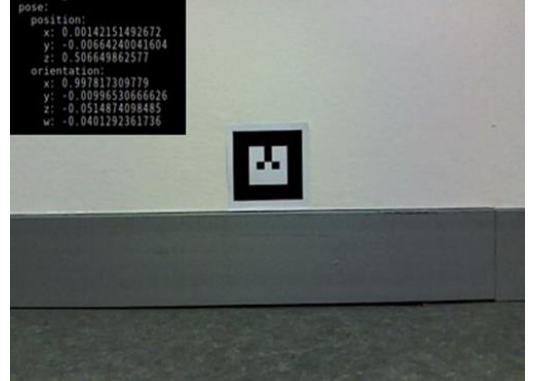
Figure 10. Energy node location and orientation estimation.